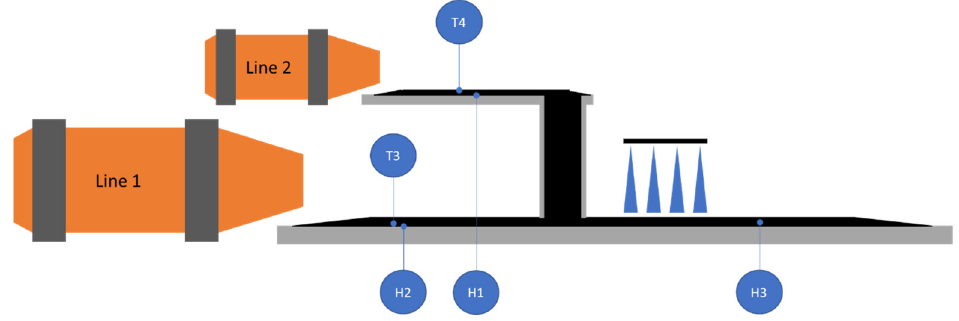
Figure 3. Diagram representing the temperature sensors (T3 and T4) and humidity sensors (H1, H2, and H3) on tapes at the exits of the cooling drums of both production lines and just before taking the sand to the silo.